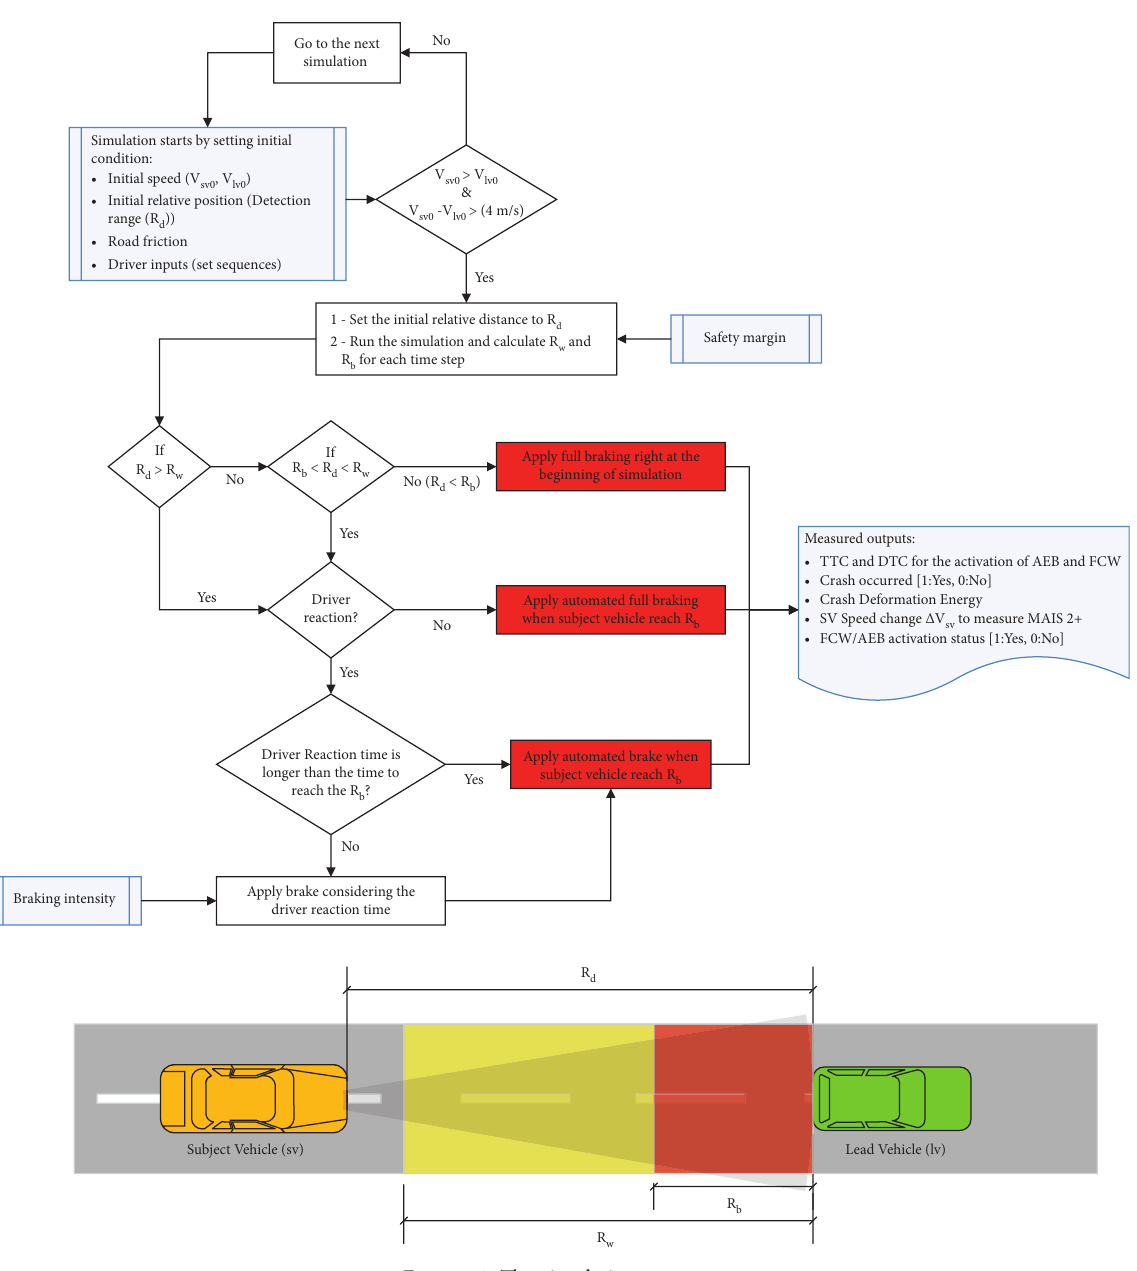
Figure 4: The simulation